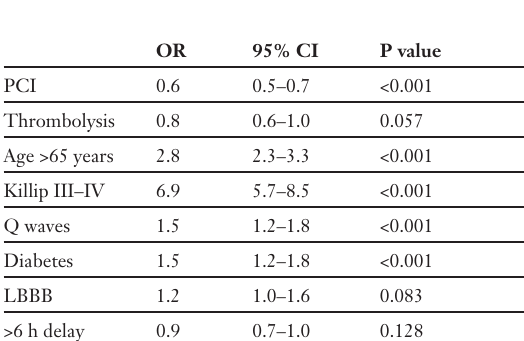
Table 4 Multivariate analysis of the composite end point predictors of major adverse car- diac events (death, reinfarction,